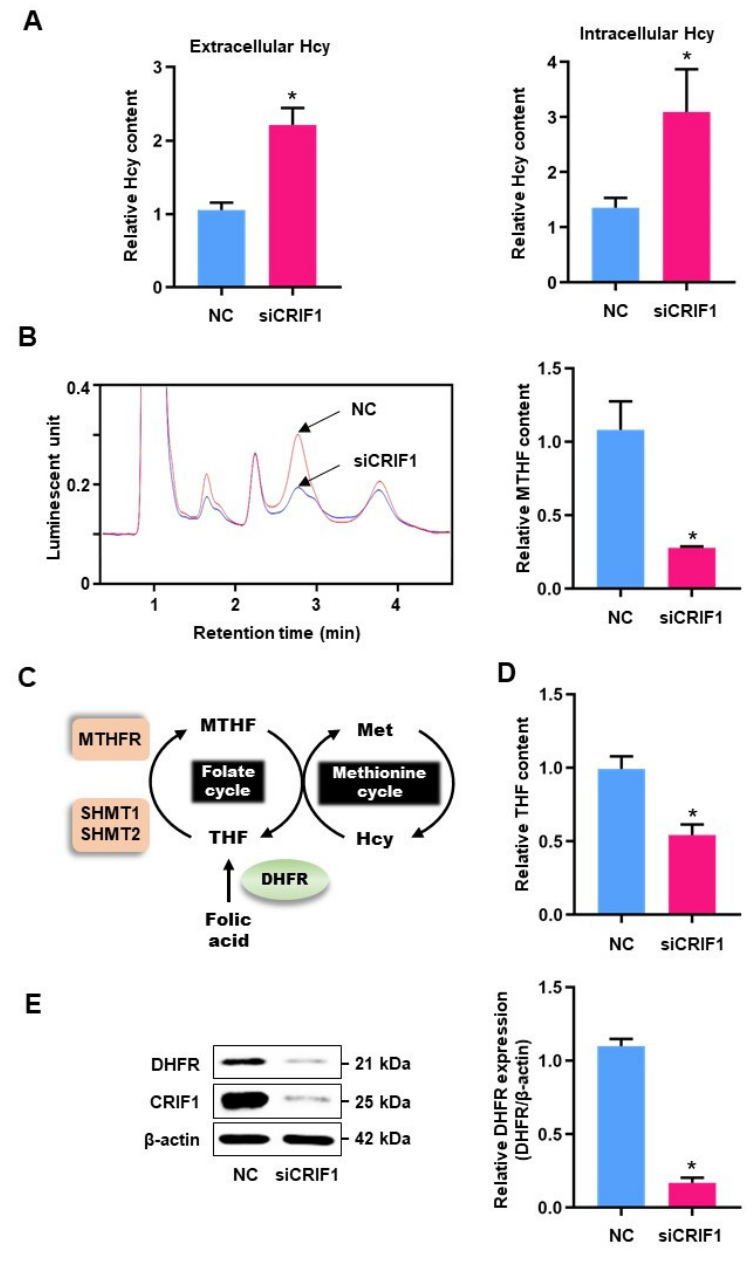
Figure 1. The levels of homocysteine, folate intermediates, and DHFR expression in CRIF1-deficienct HUVECs: ( A ) Hcy content in cells and supernatant media were measured using 100 pmol NC and siCRIF1-treated HUVECs. Relative quantitative analysis of Hcy content is shown as graph. ( B ) MTHF content of siCIRF1-treated HUVECs were analyzed using fluorescent-HPLC. Luminescent units of NC and siCRIF1-deleted HUVECs are shown as a graph ( left ), and the arrows indicate the peak of MTHF in cells. Relative quantification using peak-area is suggested as a graph ( right ). ( C ) Schematic model of the Hcy metabolism pathway via remethylation using MTHF synthesized through the FA cycle. ( D ) THF content was measured in NC and CRIF1 siRNA-treated cells. ( E ) DHFR protein expression was detected by immunoblotting. Protein level was quantified by relative densitometric assay. Data are presented with three independent experiments as the mean ± SEM. * p < 0.05 compared with NC siRNA-treated cells.